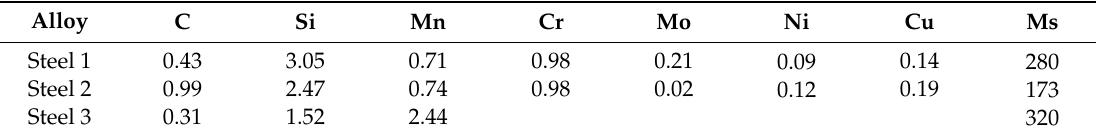
Table 1. Chemical composition of the steels in wt.%, with Fe to balance, and experimental martensite start temperature, Ms in ◦